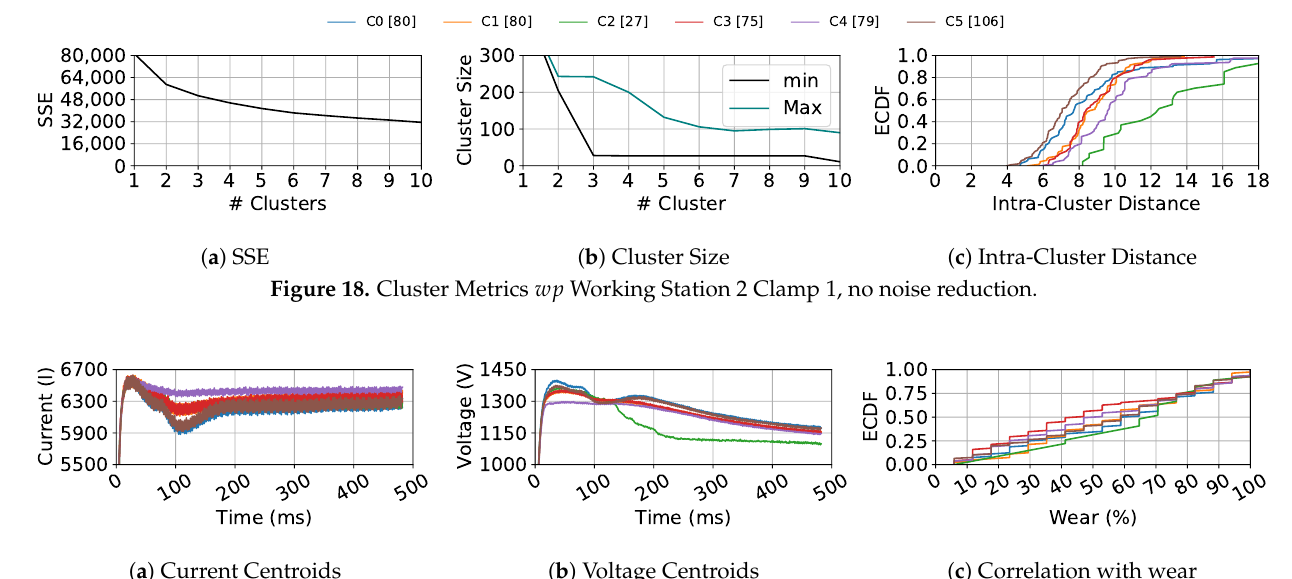
( c ) Correlation with wear